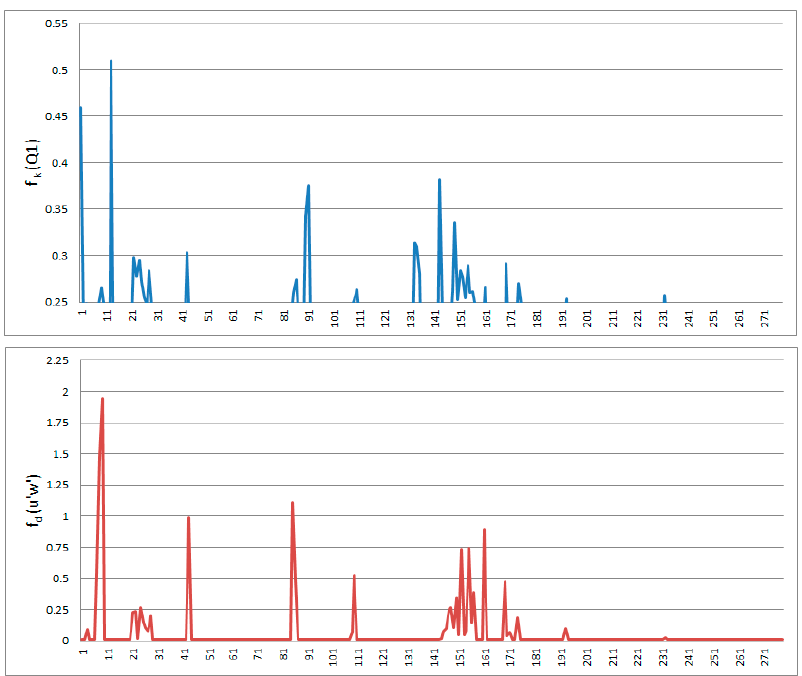
Figure 8. Values of 𝑓 (cid:3038) (𝑄1) and f (cid:2914)(cid:2931)(cid:4593)(cid:2933)(cid:4593) for 278 points in the downstream region of the vegetation patches.